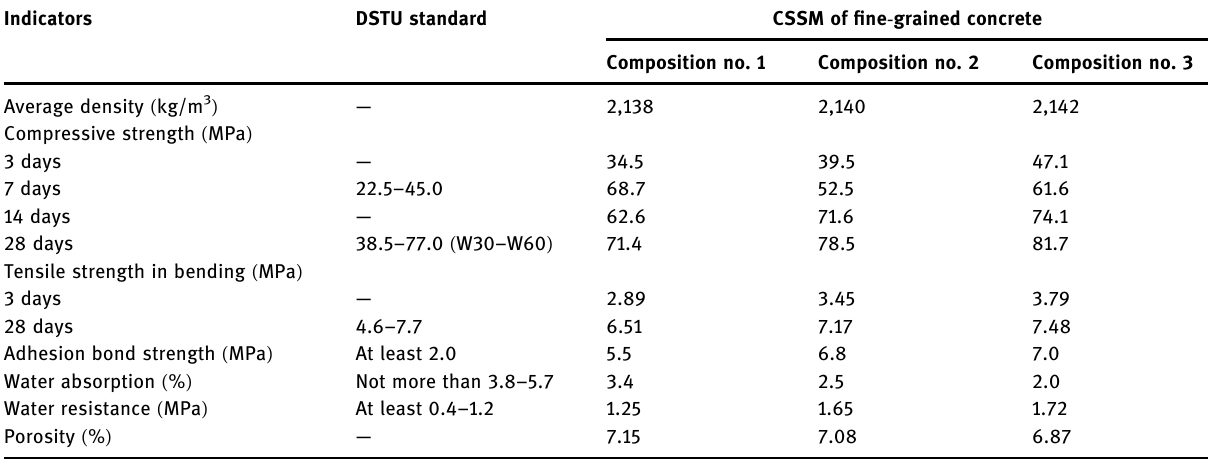
Table 10: Physical - mechanical and performance indicators of the developed compositions